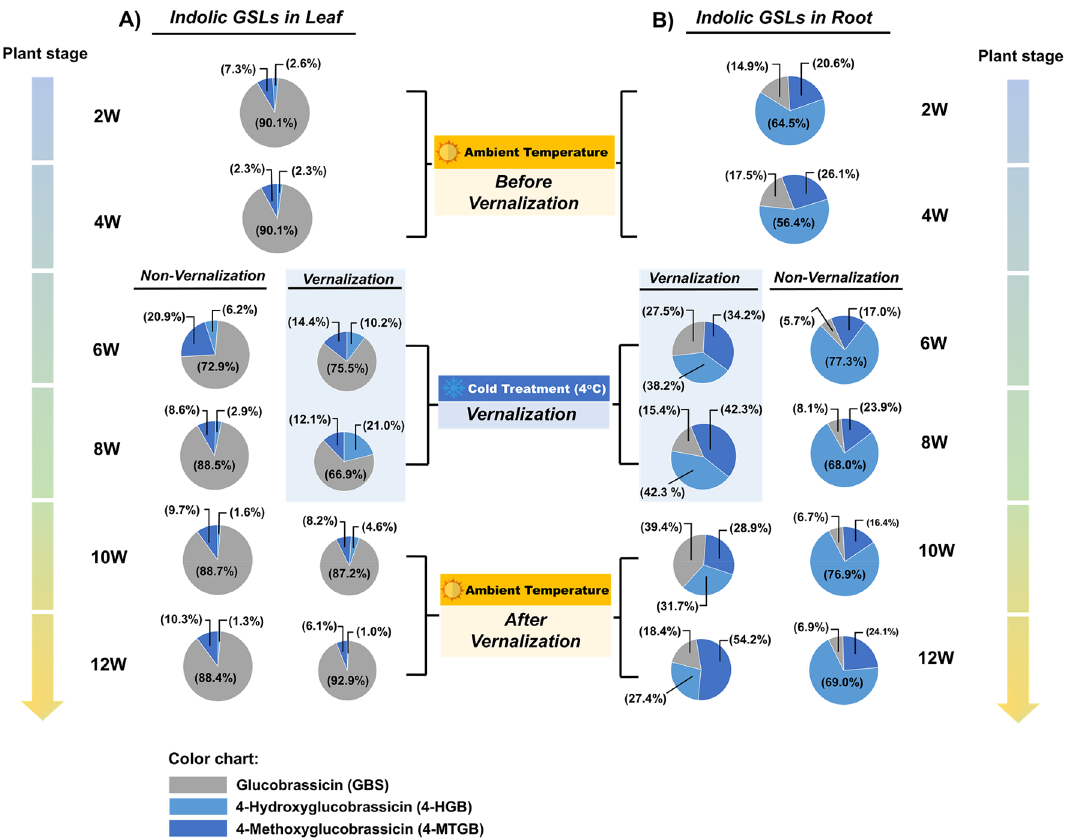
Figure 4. The indolic GSLs content and profiles of the leaves ( A ) and roots ( B ) of vernalized and non- vernalized R. sativus . The smaller size of pie-graph for the vernalization group indicated lower total indolic GSLs content compared with the non-vernalization group. Data were presented as mean ± standard deviation (SD) (n = 3). Statistically significant differences were determined by one-way ANOVA and Tukey’s post hoc test ( p < 0.05). GBS Glucobrassicin, 4-HGB 4-Hydroxyglucobrassicin, 4-MTGB